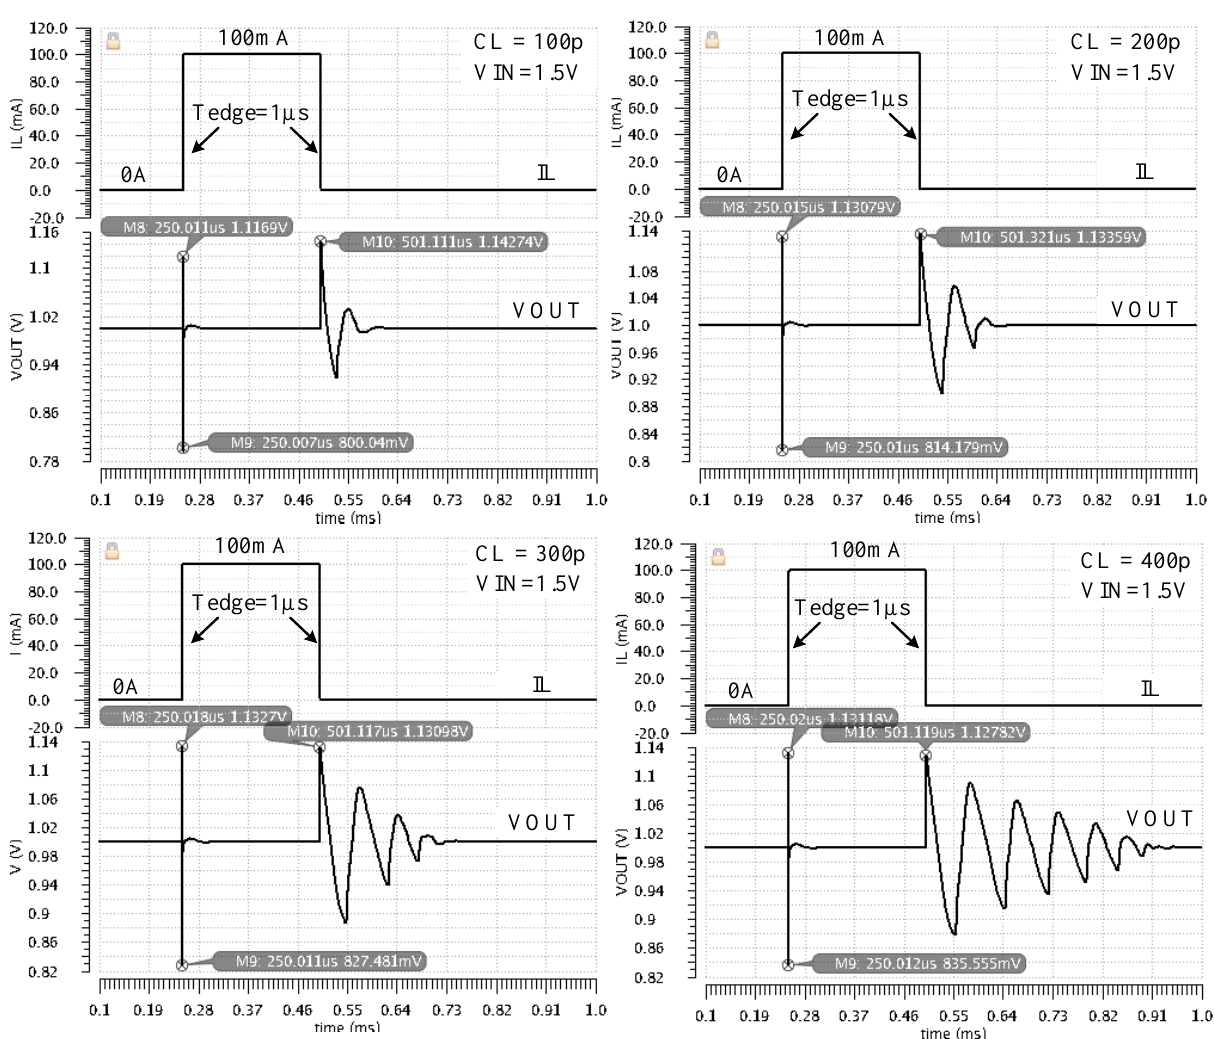
Figure 14. Simulated LDO response to load current steps for four values of CL and VDD = 1.5 V. The load current jumps from IL = 0 A to ILmax = 100 mA (at t = 250 µs) and back to zero (at t = 500 µs) in 1 µs.